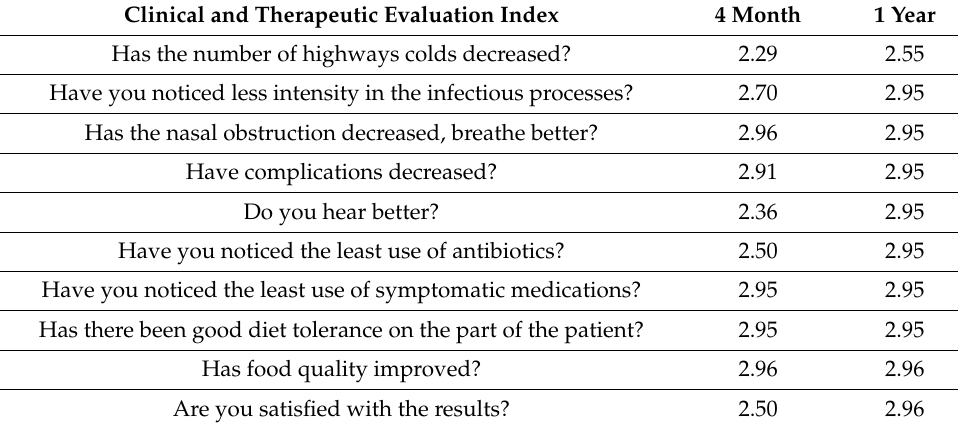
Table 1. Clinical and therapeutic evaluation index. Responses from parents or guardians regarding the improvement observed: 3: much, 2: quite, 1: something, 0: